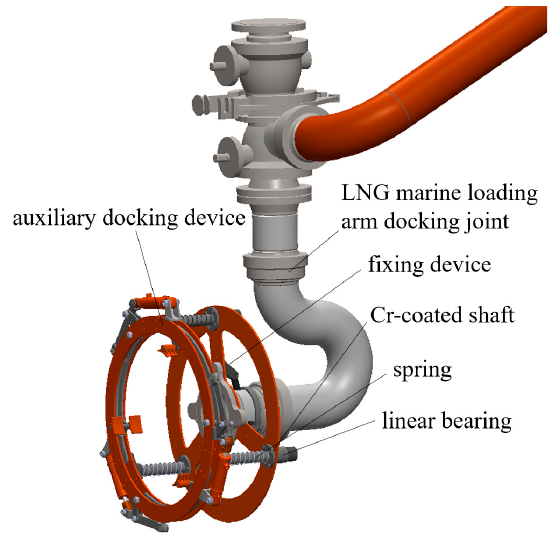
Figure 22. Joint after installing the auxiliary docking device.